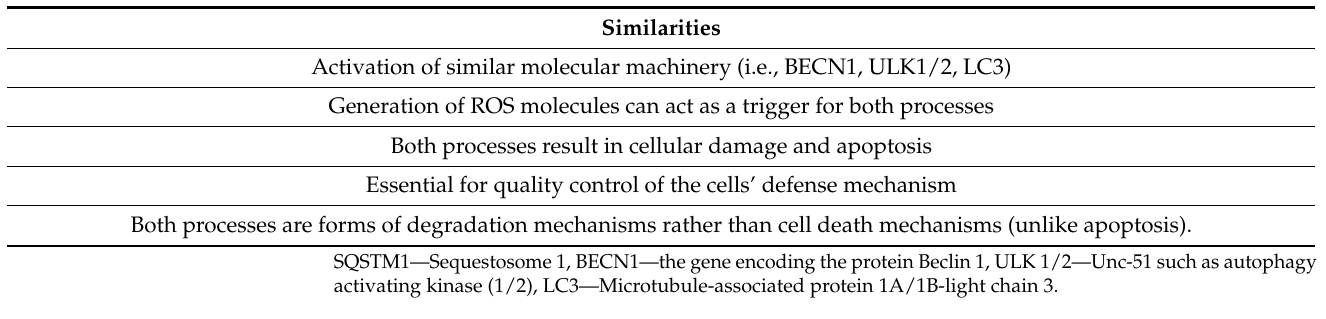
Table 2. Autophagy induced by different